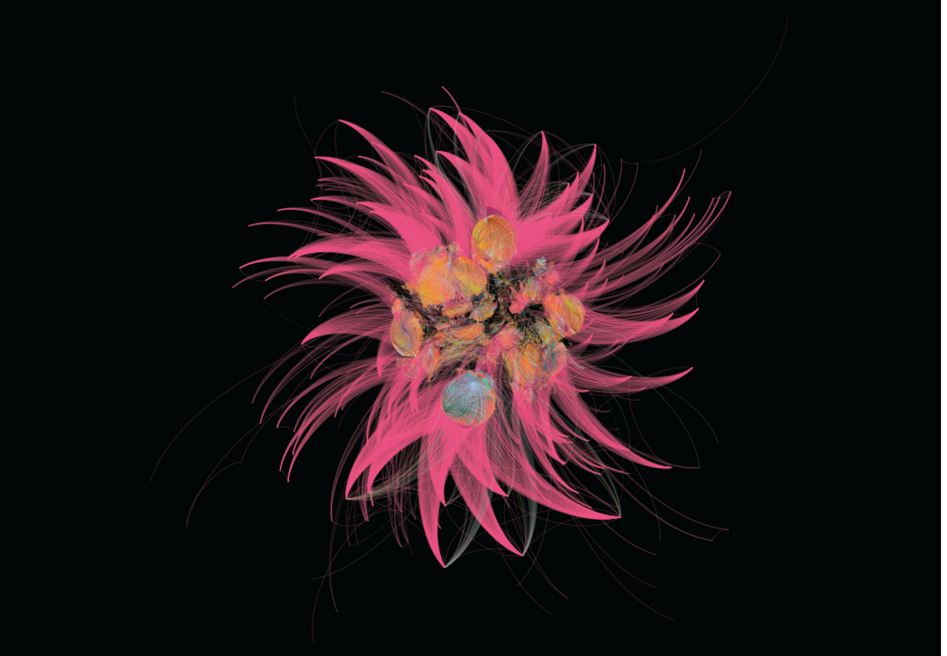
Figure 1. Six hundred and fifty handshakes. This piece of art by the bioartist François-Joseph Lapointe belongs to the series ‘1000 handshakes’. For this project, the artist shook hands with as many people as possible in various cities, gradually changing the microbial community in the palm of his right hand. Periodically, assistants have taken a skin microbiome sample and the DNA collected has been sequenced and analyzed to generate sequence similarity networks. Two bacteria (nodes) are connected in the network when their genetic sequences are more similar than a fixed threshold (90%), with different clusters corresponding to distinct bacterial families and different colors representing the microbiome samples collected at regular intervals (i.e., every 50th